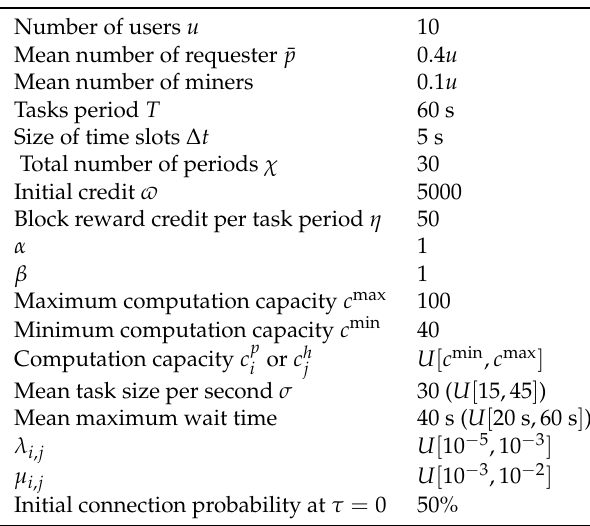
Table 1. Default simulation parameters.